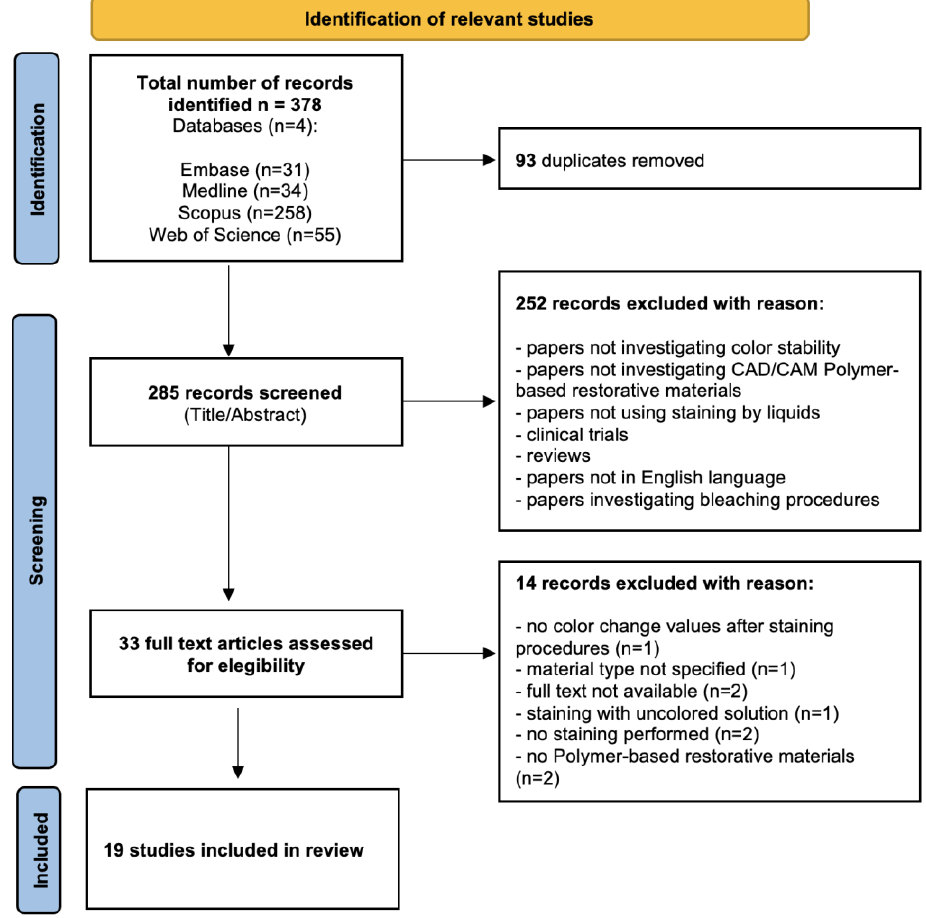
Figure 1. Identification of relevant studies.